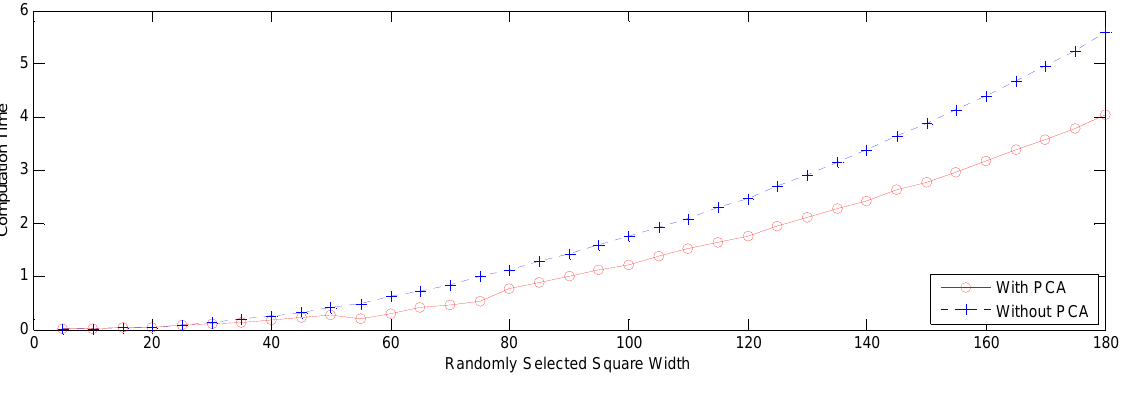
Figure 29. The overall accuracy versus square